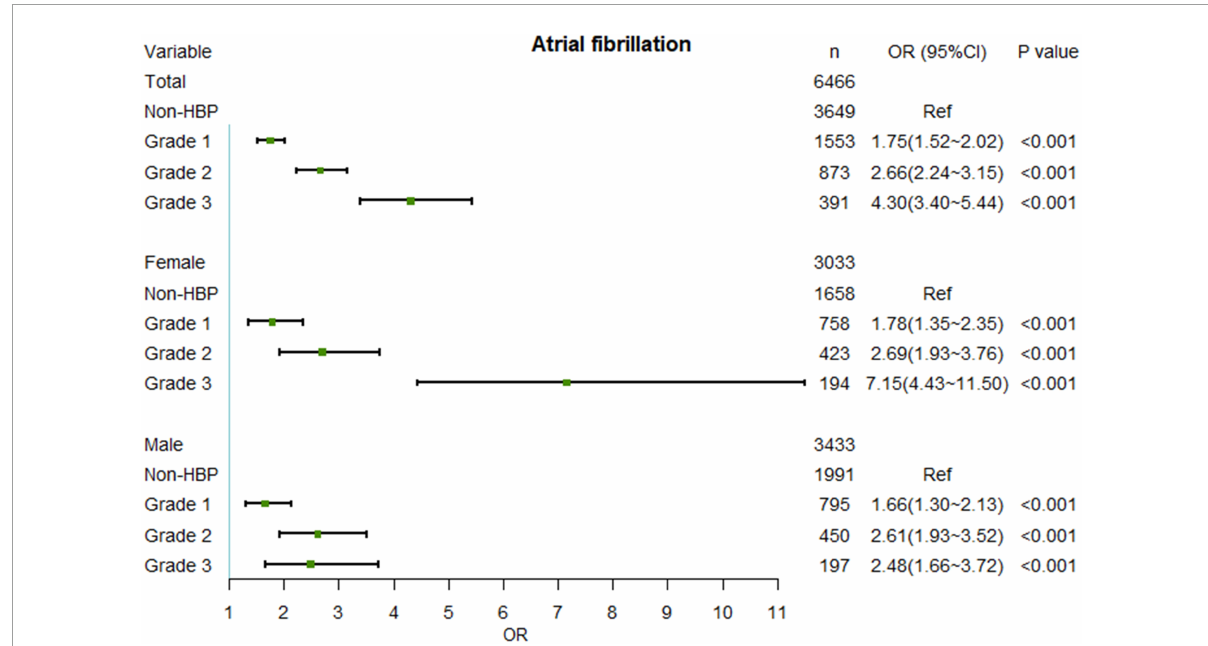
FIGURE2 Relationship between AF and different HBP level after PSM. No interaction effects existed between sex and HBP levels. AF, atrial fibrillation; OR, odd ratio; HBP, hypertension; PSM, propensity score matching.